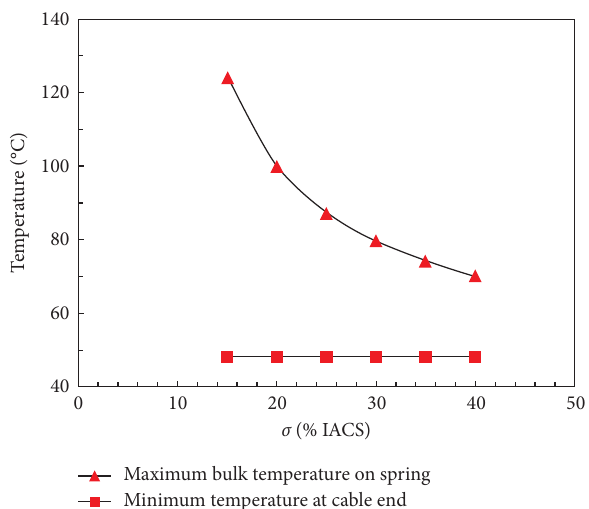
a vs. ΔT . (b) h b vs. ΔT .